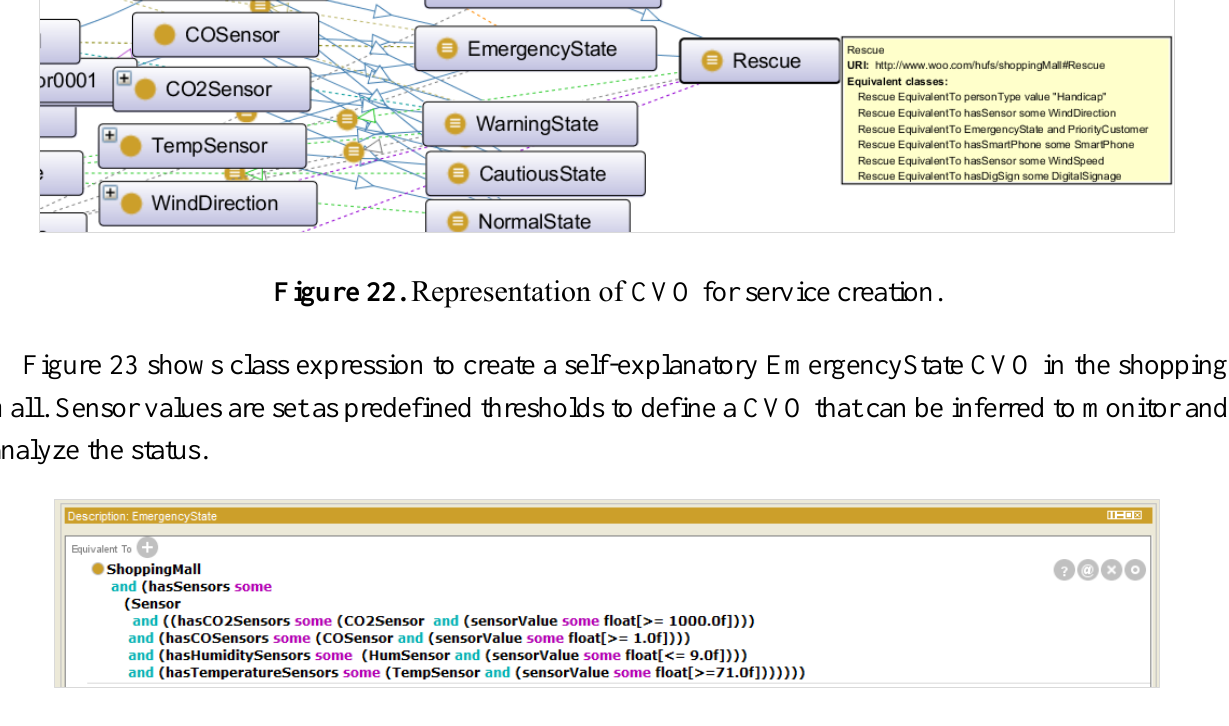
Figure 23. Class expression for EmergencyState CVO defined in